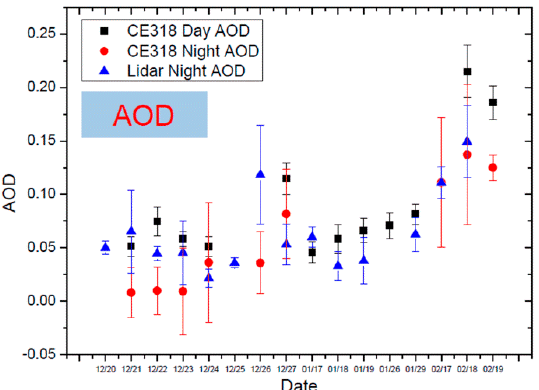
Figure 11. Aerosol optical depth (AOD) of lunar-photometer CE-318U, Sun-photometer CE-318 and AMPLE for lunar observations in Lijiang city. The combined lidar, sun-photometer, and lunar-photometer system was implemented in site and checked to derive the nighttime aerosol backscatter and extinction data products.